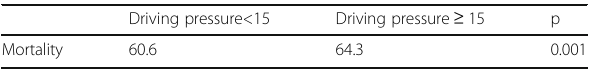
Table 1 (abstract 001529). Driving pressure and Mortality